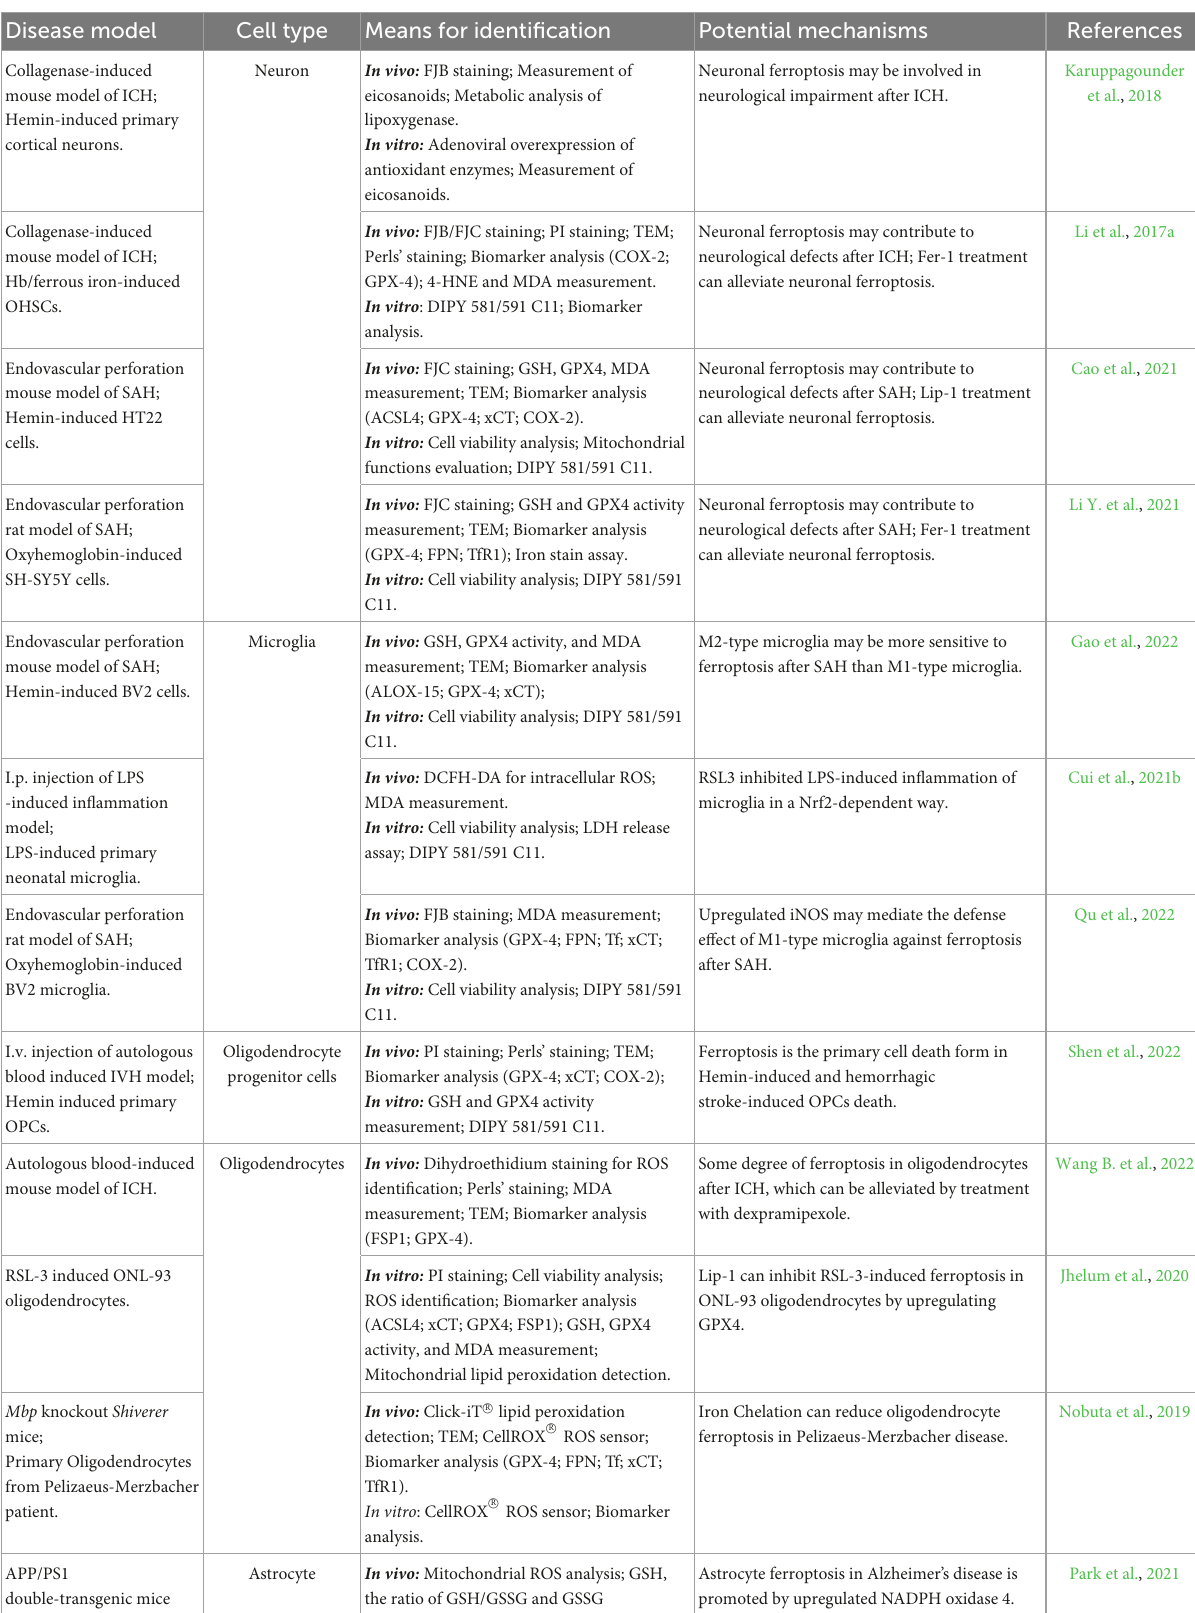
TABLE 1 Ferroptosis in different cell types in the central nervous system